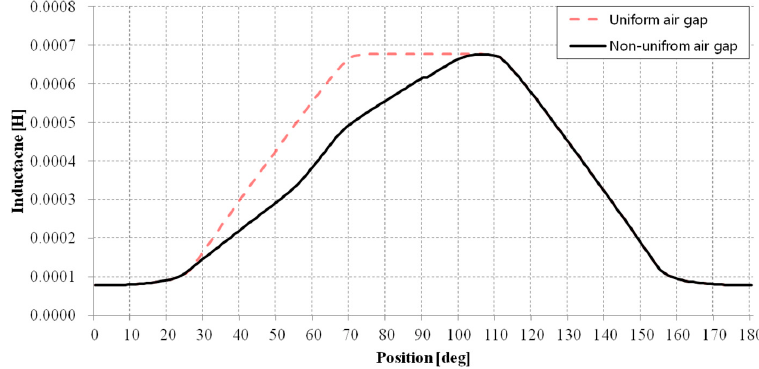
Figure 8. Comparison of the inductance profiles for the two different air gap configurations. Figure 9 is the two different air gap configurations: (a) cross section of the non ‐ uniform air gap; (b) cross section of the uniform air gap. Figure 10 is the cross section of the prototype rotor model.